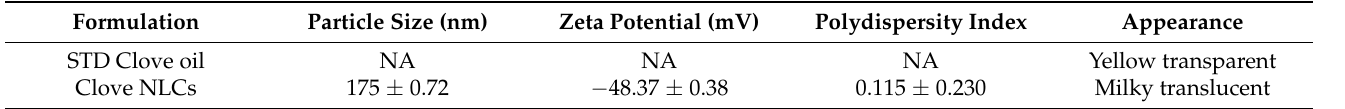
Table 2. Physicochemical characterization of clove oil NLCs. Formulation Particle Size (nm) Zeta Potential (mV) Polydispersity Index Appearance STD Clove oil NA NA NA Yellow transparent Clove NLCs 175 ± 0.72 − 48.37 ± 0.38 0.115 ± 0.230 Milky